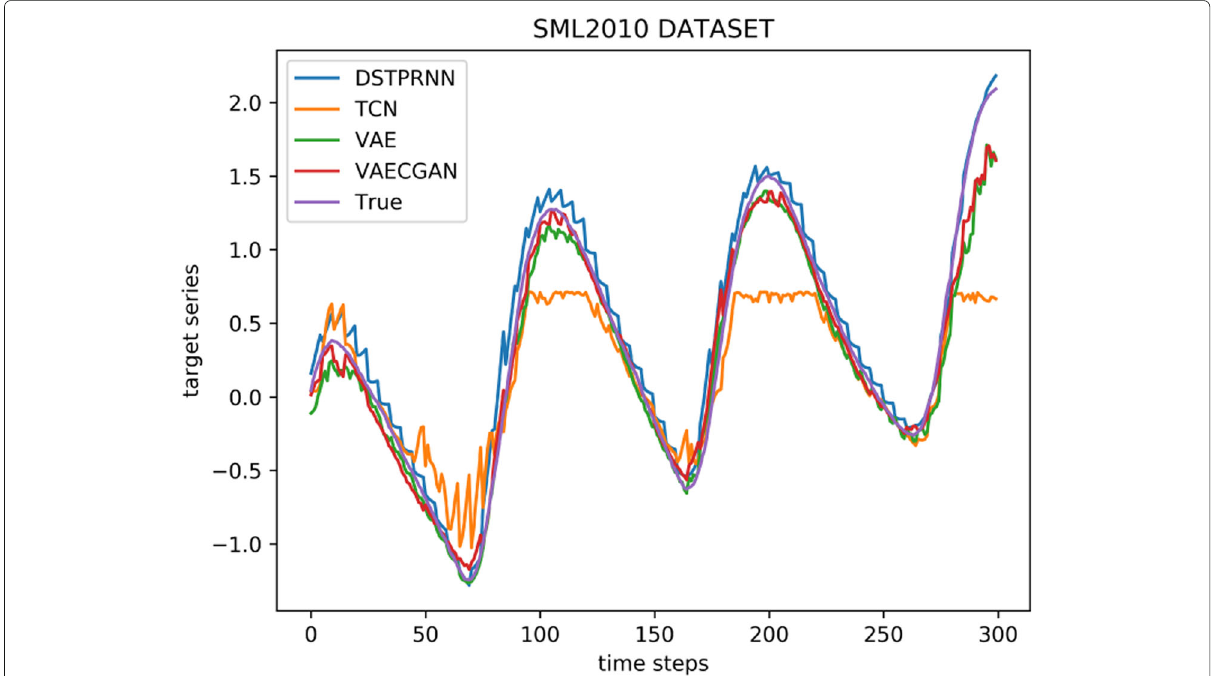
Fig. 3 The detail of time series prediction results over SML Datasets